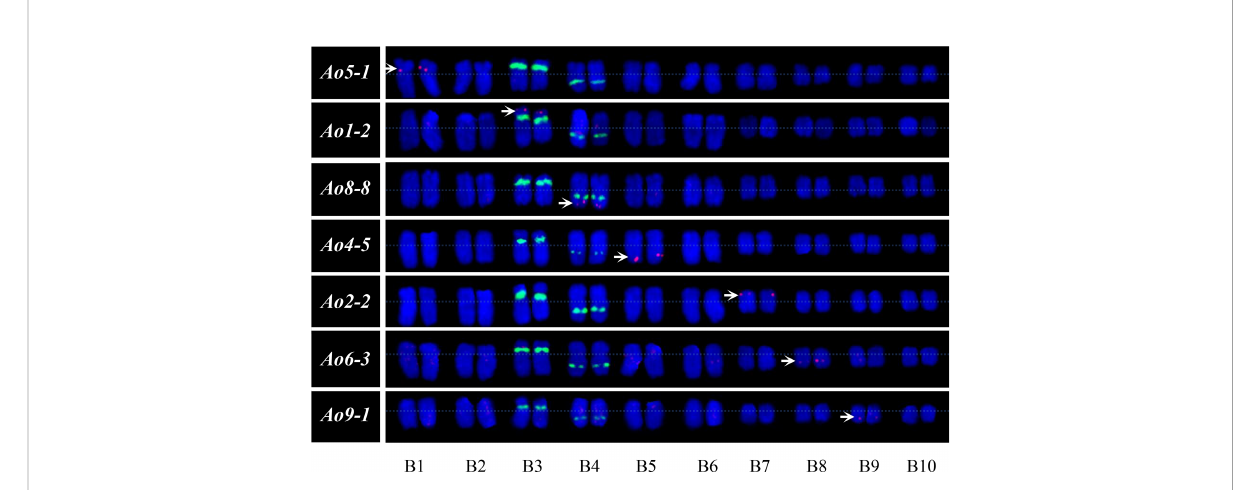
FIGURE 7 Orthologous relationship analysis and karyotype of A. setaceus based on FISH analysis using garden asparagus chromosome-speci fi c single copy genes. The arrows denote the chromosome-speci fi c FISH signal (red). The green fl uorescence represents the signals of 45S